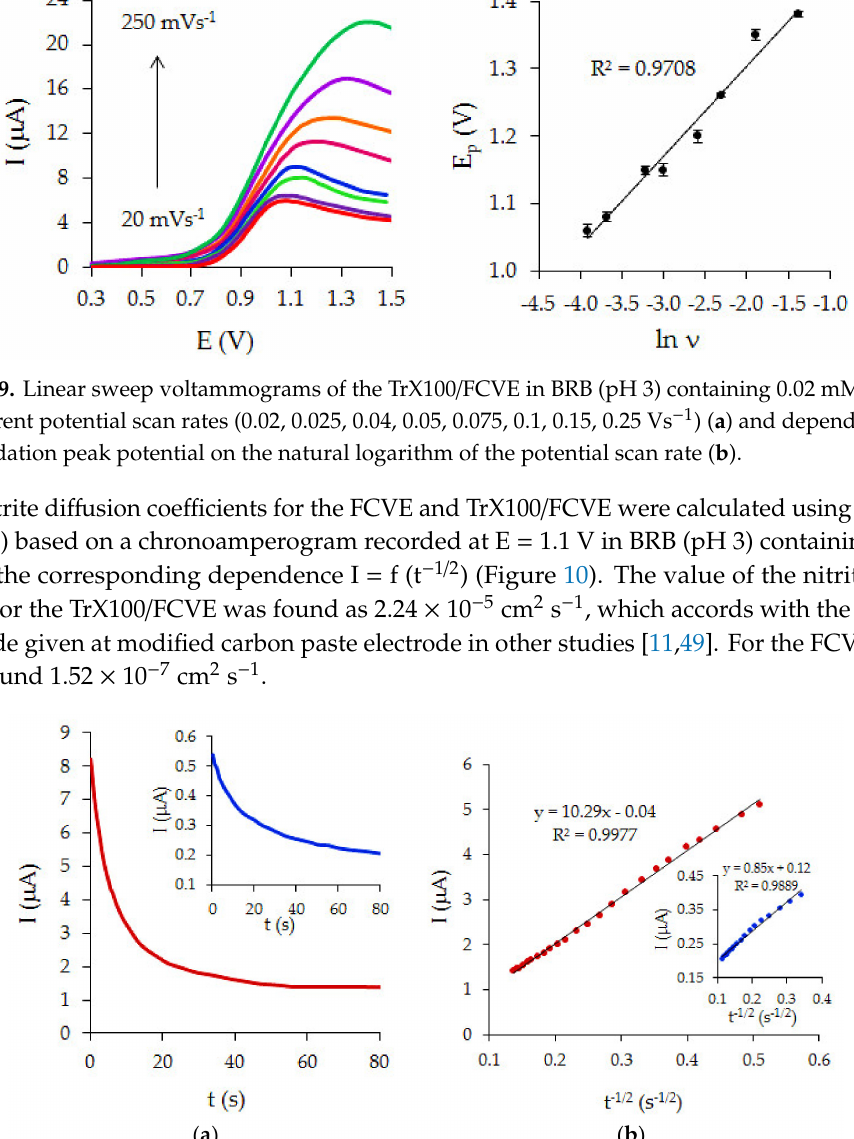
Figure10. Chronoamperogramsobtainedatpotential1.1VontheTrX100 / FCVEinBRB(pH3)containing 0.02 mM NO 2 − ( a ) and corresponding dependence I = f (t − 1 / 2 ) ( b ). Insert: ( a ) chronoamperograms obtained at potential 1.1 V on the FCVE in BRB (pH 3) containing 0.02 mM NO 2 – and ( b ) corresponding dependence I = f (t − 1 / 2